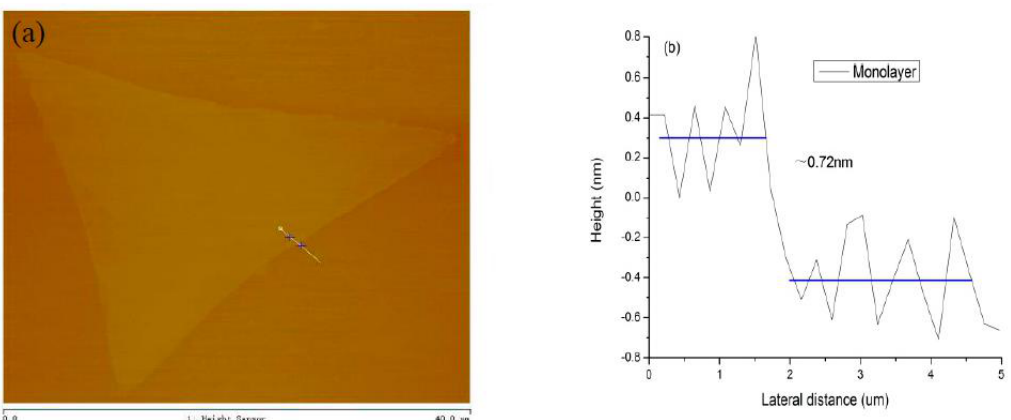
Figure 9. ( a ) Two-dimensional AFM topography image of the monolayer MoS 2 ; ( b ) Height profile of the monolayer MoS 2.